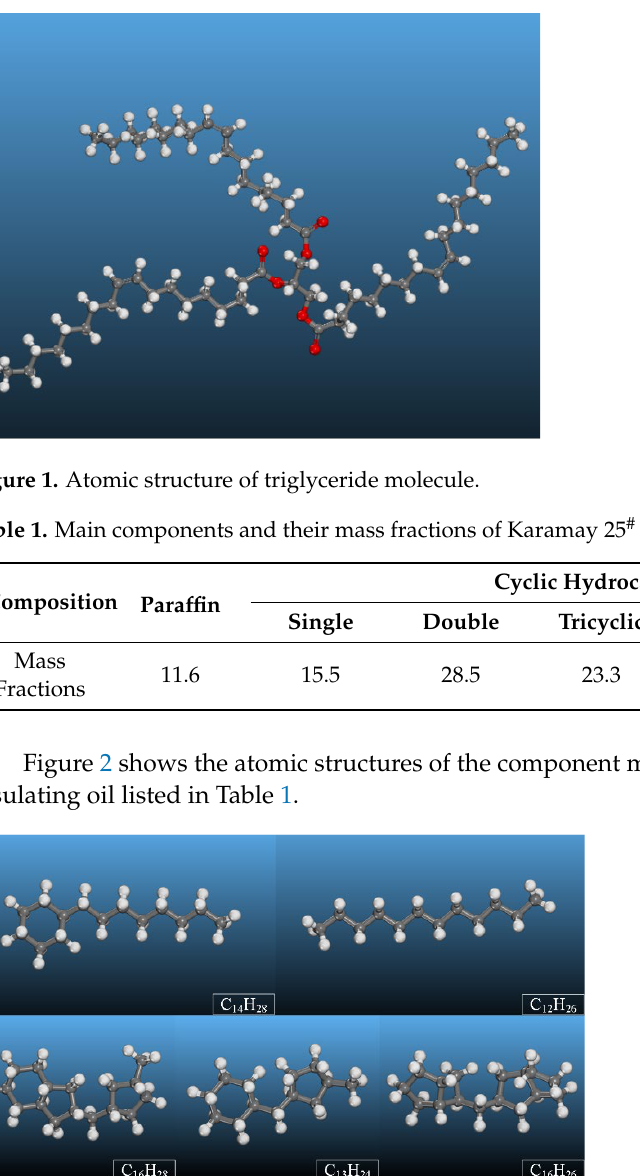
Figure 2. Atomic structures of the main constituent molecules in the Karamay 25 # insulating